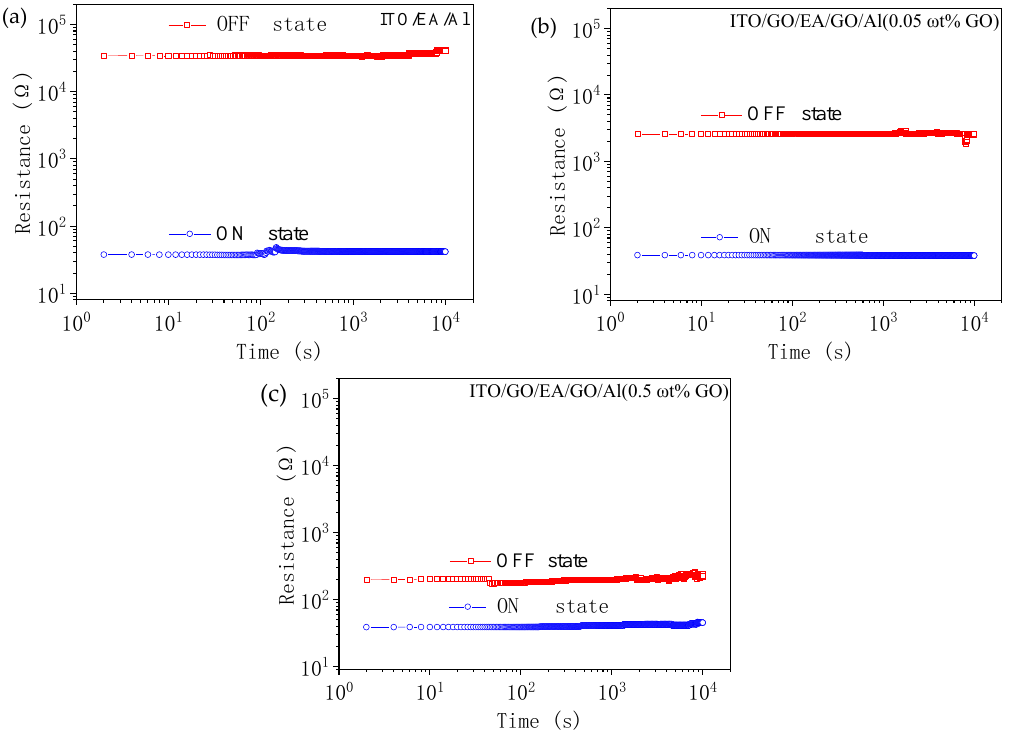
Figure 10. Retention times of ( a ) the ITO/EA/Al device and ( b – c ) the ITO/GO/EA/GO/Al devices with GO concentrations of ( b ) 0.05 ωt% and ( c ) 0.5 ωt%.